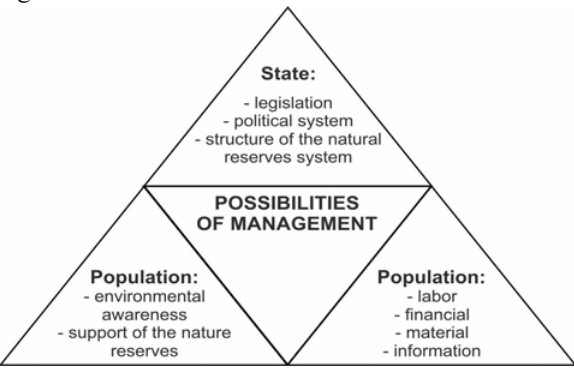
Fig. 1. Factors that form the system of management of na- ture